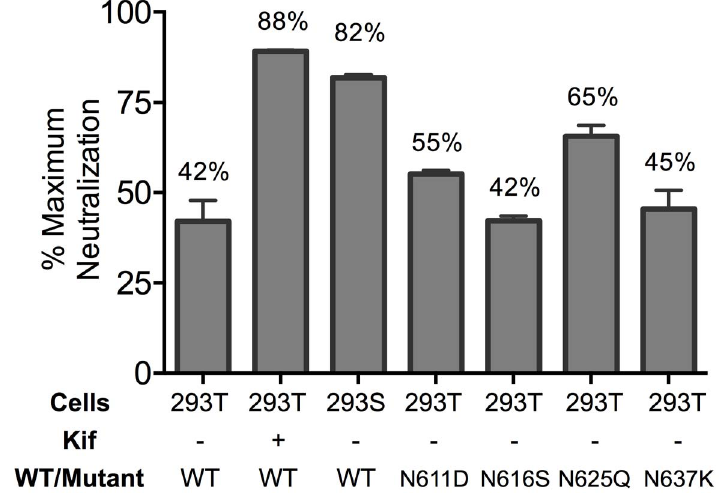
Figure 3. Glycosylation state of MPER mutant HIV-1 Env influences extent of maximum neutralization by 10E8. The JR2 F673L mutant was subjected to various glycosylation conditions and the corresponding viruses were tested in a neutralization assay against 10E8 using TZM-bl target cells to determine the maximum neutralization percentage.